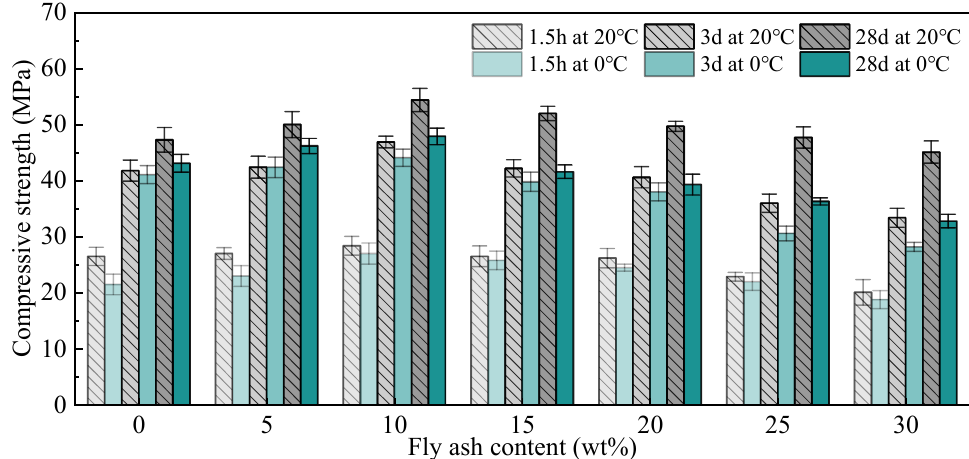
Figure 4. The variation of compressive strength with mixing temperature and fly ash content.